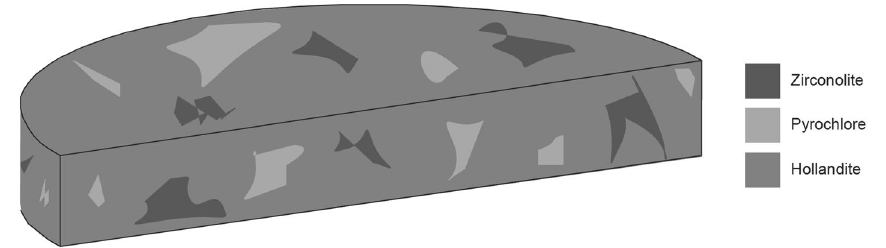
Figure 1. Schematic of a designer waste